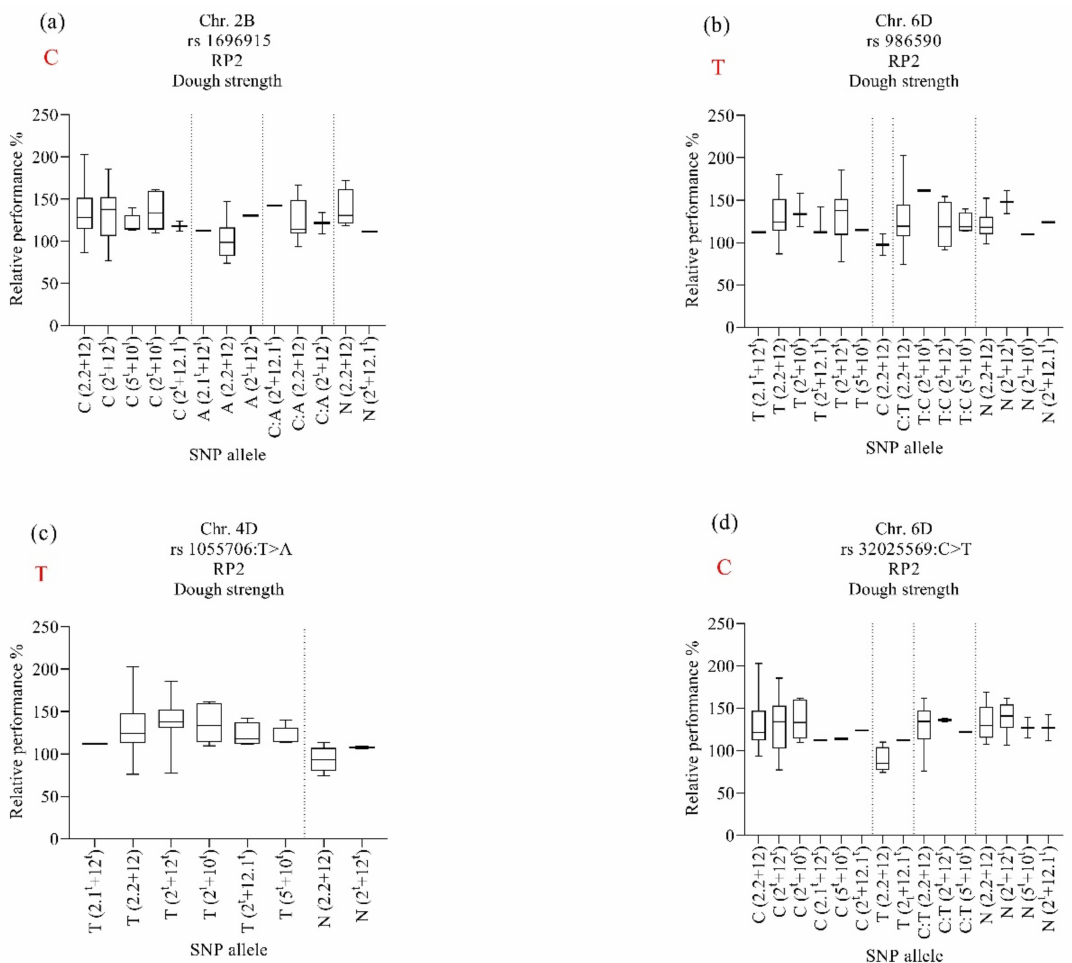
Figure 7. Effect of selected marker–trait associations ( a – d ) on relative performance of dough strength (PR2) in lines with different HMW-GS in MSD lines grown under heat stress. A, adenine; C, cytosine; T, thymine; G, guanine; N, unknown. Alleles in red refer to those of the backcross parent of the population, ‘Norin